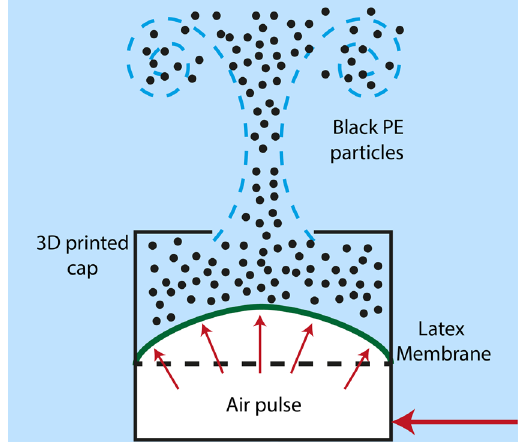
Figure 2. Schematic drawing of the vortex ring generator. Pulsed air is introduced into the enclosed bottom chamber, pushing a latex membrane to force out a fraction of the fluid in the chamber through a circular orifice, thus creating a vortex ring. The liquid inside the chamber has been pre-seeded with black